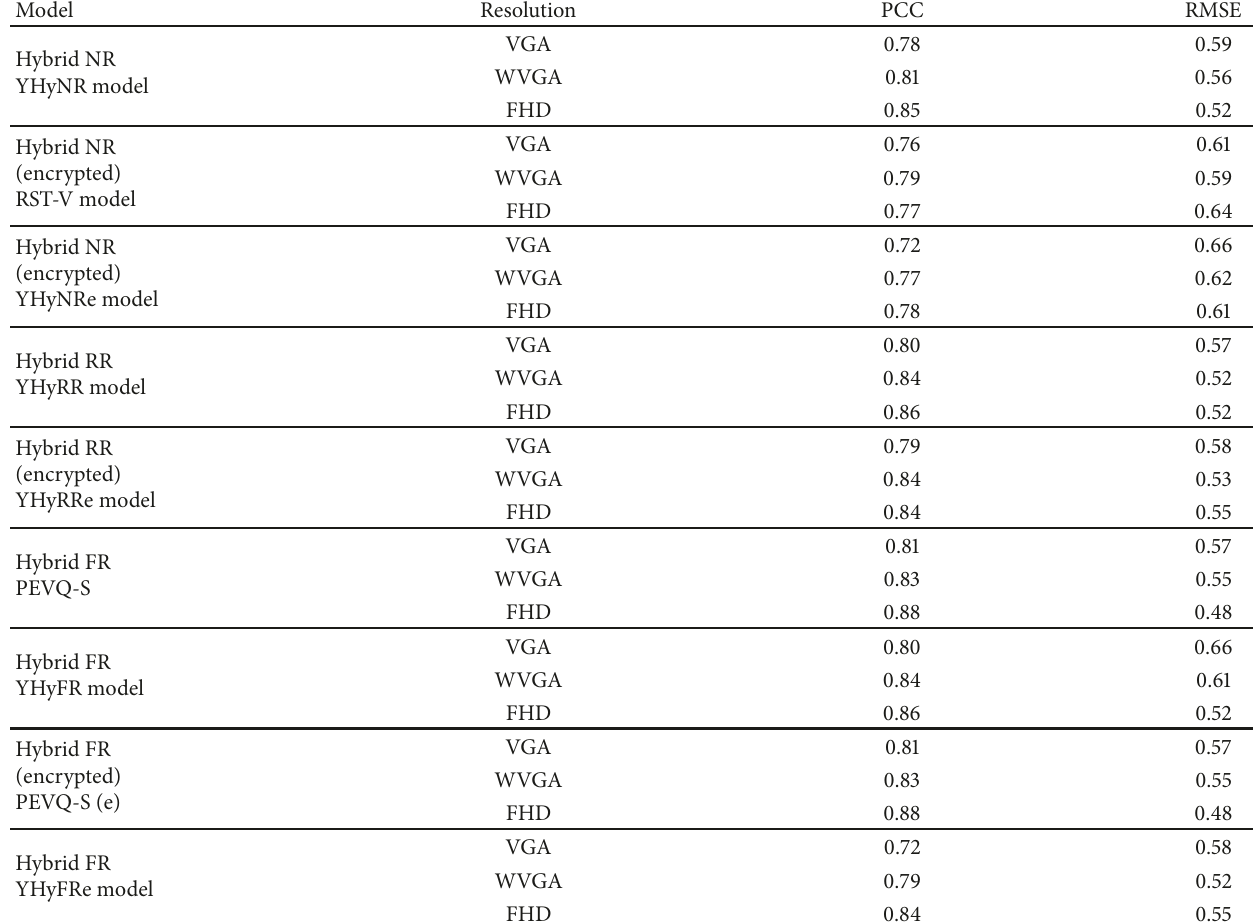
Table 15: Model performance